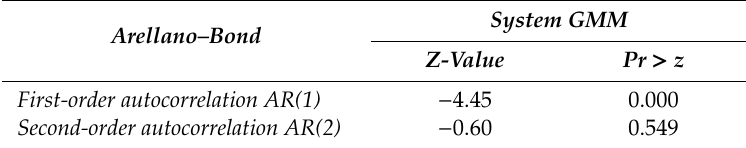
Table 5. Arellano-Bond test for the partially aggregated pecking order